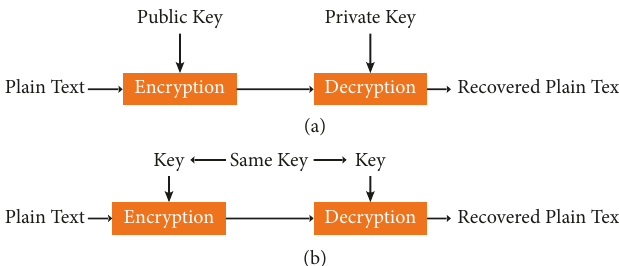
Figure 2: Key types: (a) asymmetric key and (b) symmetric key.